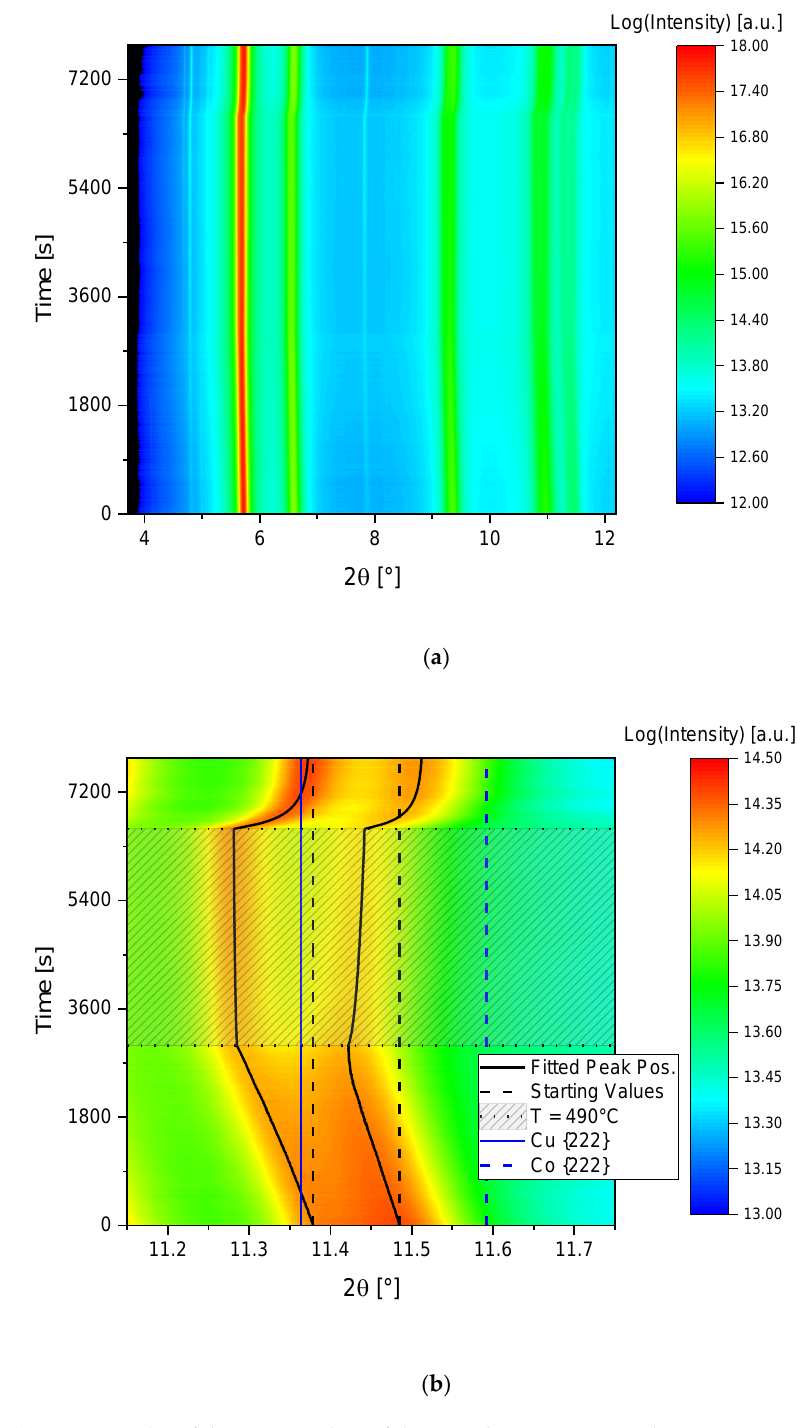
Figure 3. ( a ) Intensity plot of the HEXRD data of the complete in-situ annealing treatment of Cu 55 Co 45 . The detailed view at high diffraction angles, ( b ), gives a better view on peak shifts as a function of applied temperature. The fitted center position of {222}-peaks of Cu and Co, including the starting values, the position of {222}-peaks for the pure elements, as well as the region of constant temperature (T max = 490 °C) are presented. The heating curve is provided in Figure 4.